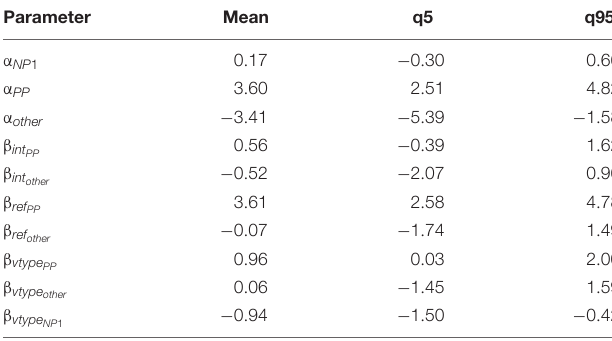
TABLE 16 | Mean estimate and credible interval for the parameters of the Bayesian model, Experiment 2.